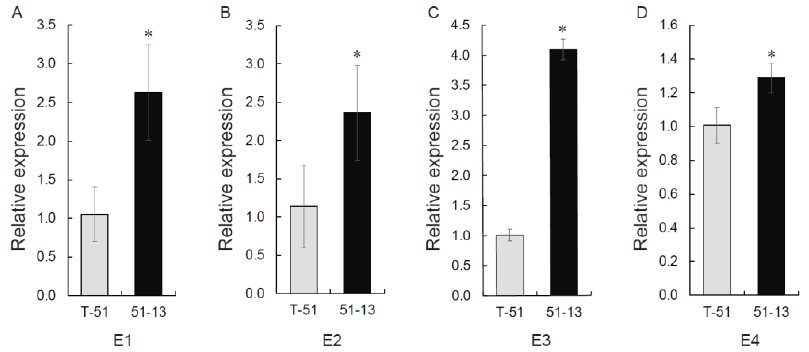
Figure 9. Relative quantification of four genes probably involved in the synthesis of p-coumaric acid methyl ester, which were selected by upregulation in transcriptome analysis. The data are expressed as means ± SD (n = 4). * p < 0.05; student’s t -test. ( A ) E1, ( B ) E2, ( C ) E3, ( D )